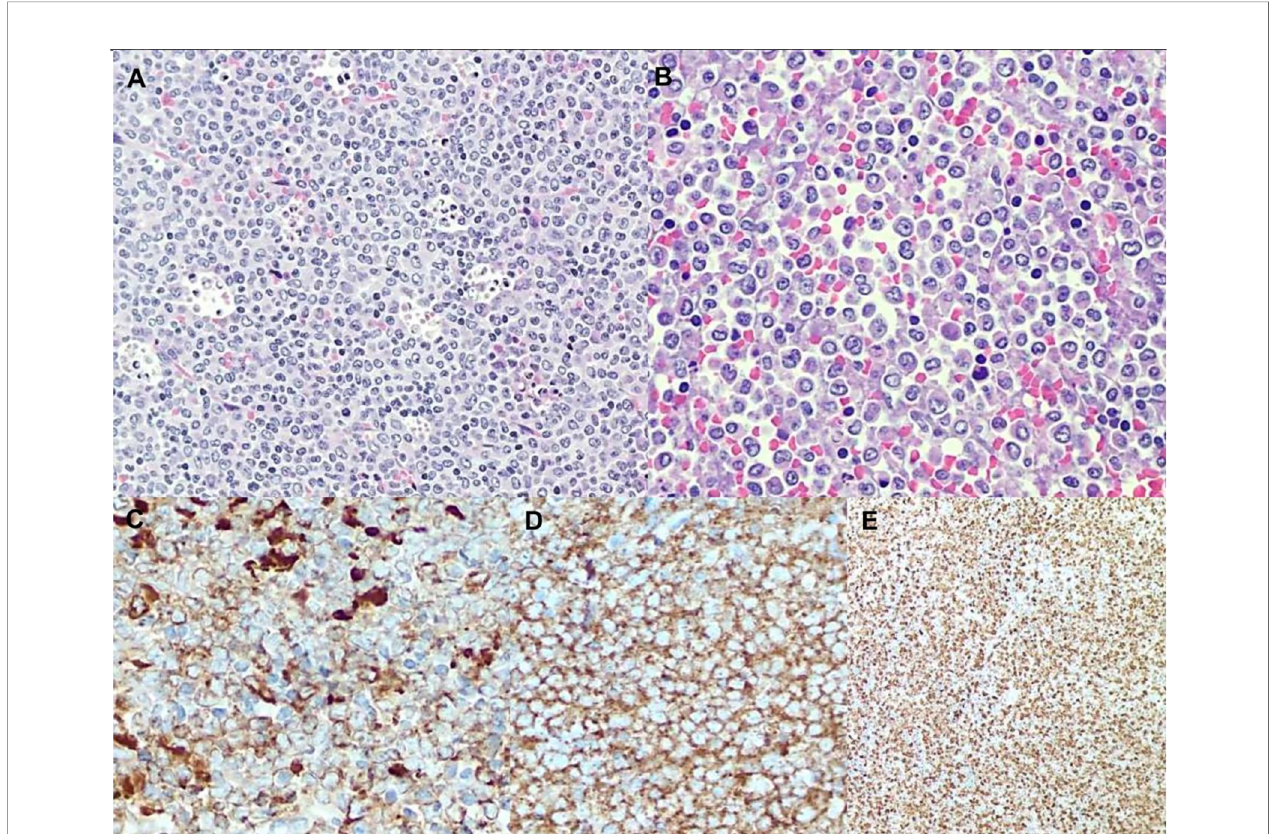
FIGURE 1 | (A) low magni fi cation shows a blastic population with diffuse pattern of growth admixed with a lot of tingible body macrophages and apoptotic debris. (B) High magni fi cation reveals blastic immature promyelocytes with hypergranular eosinophilic cytoplasm, kidney-shaped or lobed nuclei and prominent central nucleoli. Immunohistochemistry shows a diffuse and strong expression of both MPO (C) and CD33 (D) along with very high proliferation index Ki67 (E)